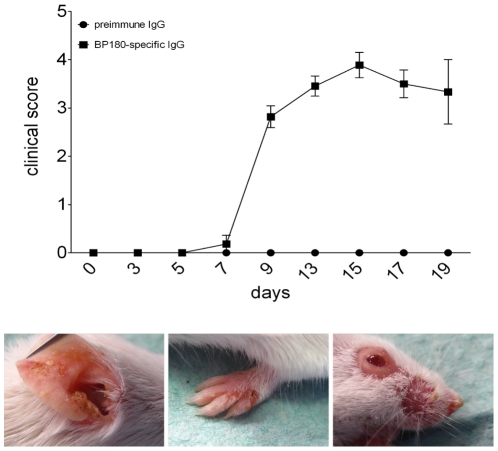
Repeated injections of antibodies against murine BP180/CXVII induce extensive skin blistering.The extent of disease was scored as described in Methods. Means of individual clinical scores of mice injected with BP180/CXVII-specific antibodies (n = 9) and mice injected with normal rabbit IgG (n = 5) are shown before the first injection as well as every subsequent second day for 19 days. The lower panel shows BALB/c mice at day 12 after the first i.p. injection.